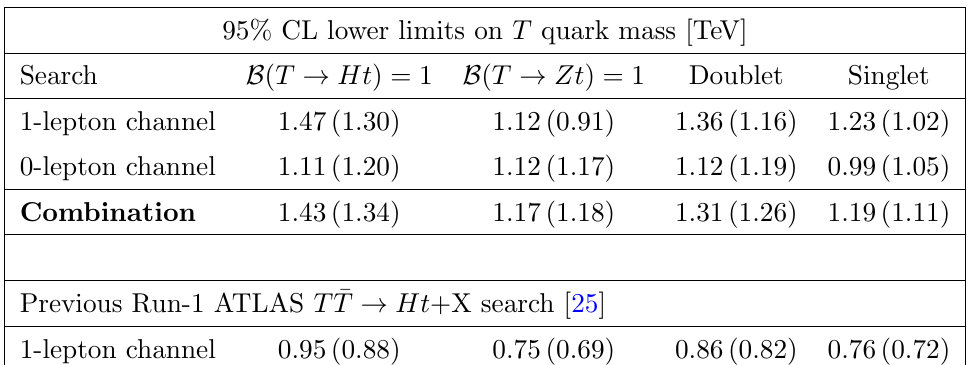
Table 8. Summary of observed (expected) 95% CL lower limits on T quark mass (in TeV) for the 1-lepton and 0-lepton channels, as well as their combination, with di(cid:11)erent assumptions about the decay branching ratios. The background estimate used in the computation of the limits is the result obtained from the background-only (cid:12)t to data. Also shown are the corresponding limits obtained by the Run-1 ATLAS T (cid:22) T Ht +X search in the 1-lepton channel [25]. !